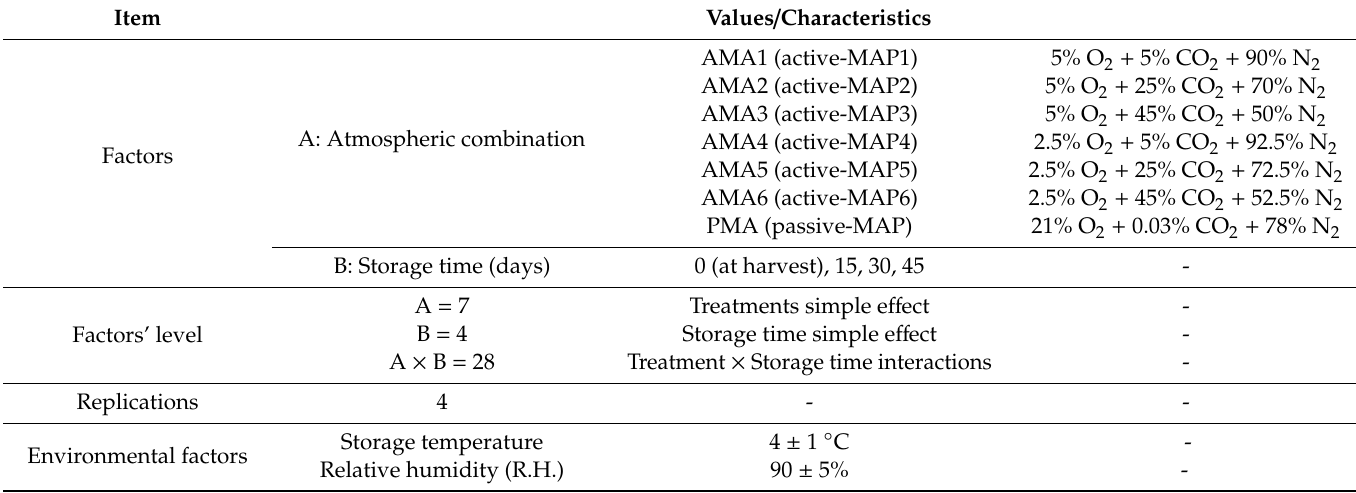
Table 1. Experimental factors and di ff erent active-modified atmosphere packaging (MAP) (AMA) and passive-MAP (PMA) atmospheric treatment combinations used in this